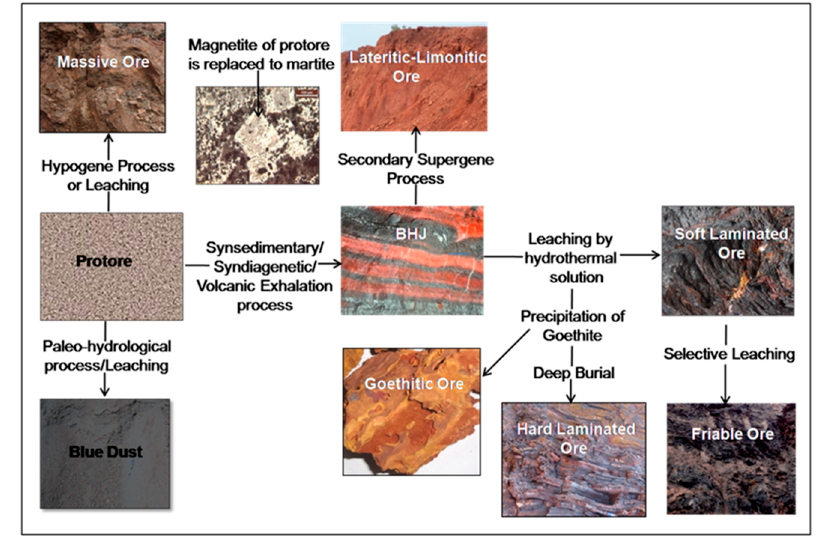
Figure 12. Schematic diagram showing possible evolution of different types of iron ores at KMIOD from proto-ore and BHJ aided by the rheological features of various lithological units modified after [9,34].